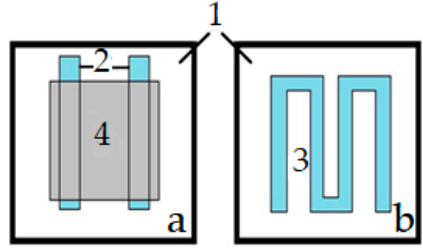
Figure 2. The gas sensor on the side of the sensitive layer ( a ) and the heater ( b ): 1 ‐ sapphire substrate; 2 ‐ platinum electrodes; 3 ‐ heater; 4 ‐ SnO 2 film.